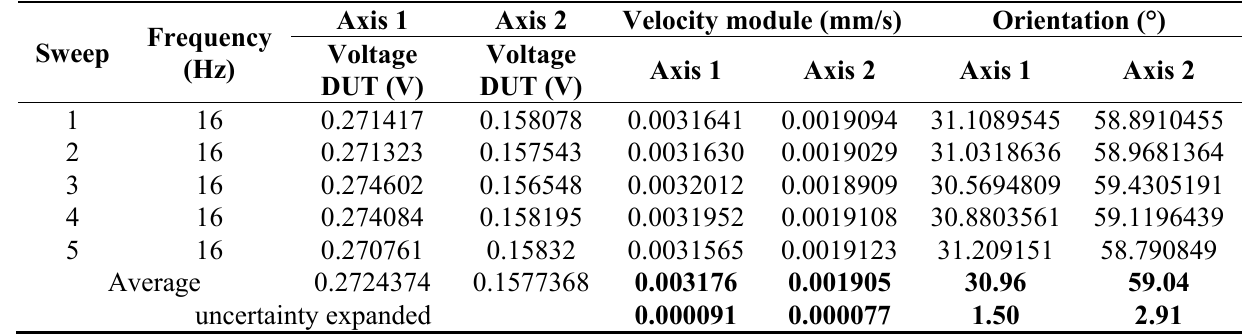
Table 5. Determination of